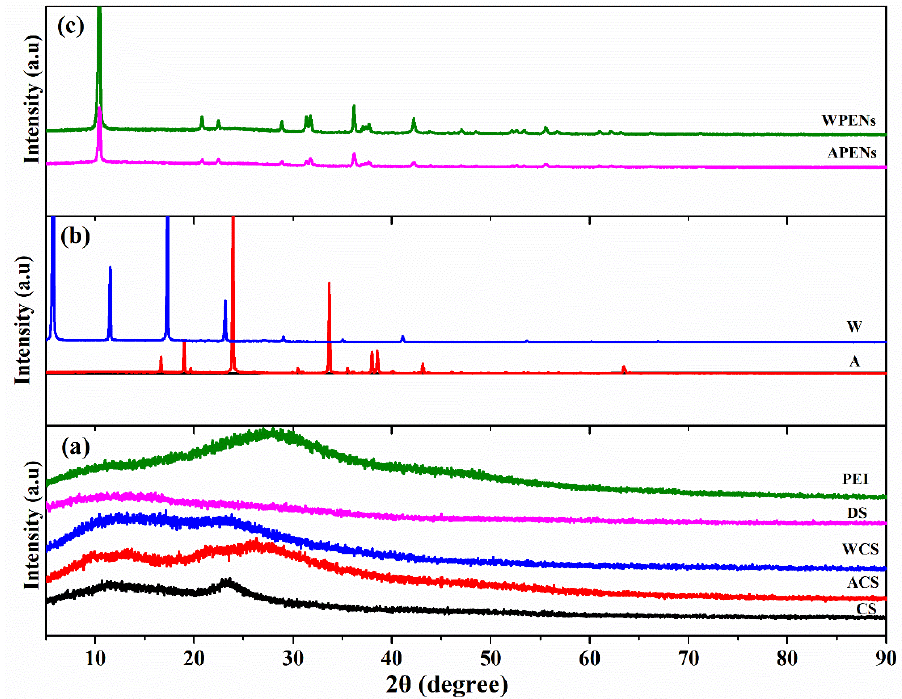
Figure 5. X-ray diffractograms of CS, ACS, WCS, DS, and PEI ( a ); A, W ( b ); and PENs (APENs and WPENs) ( c ).